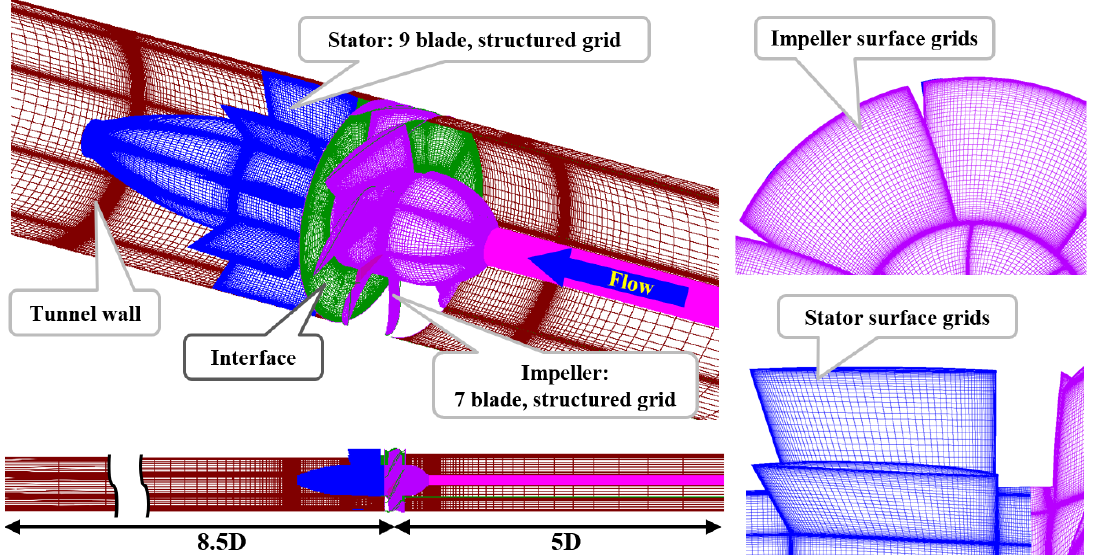
Figure 3. Grid system of impeller and stator. Figure 3.